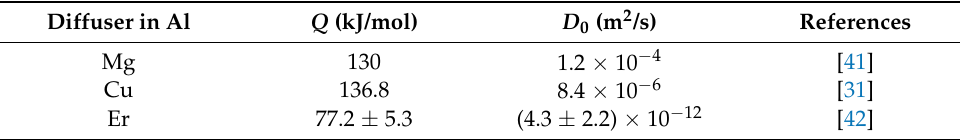
Table 2. The Q and D 0 of some diffusion systems. Diffuser in Al Q (kJ/mol) D 0 (m 2